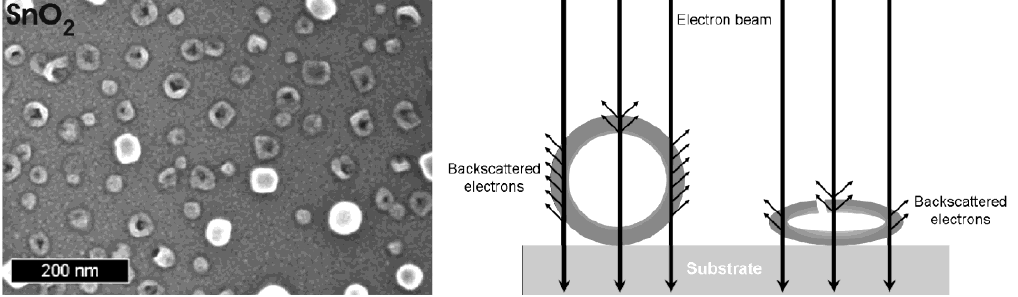
Figure 10. SEM images of partly destroyed SnO the different contrast and charging of destroyed and intact hollow spheres (reproduction from